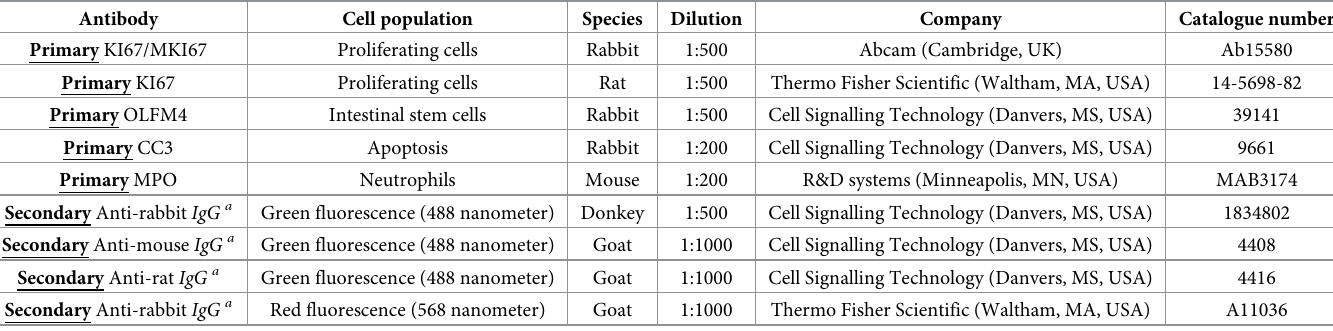
Table 2. Antibodies used for immunofluorescence of the ileum.